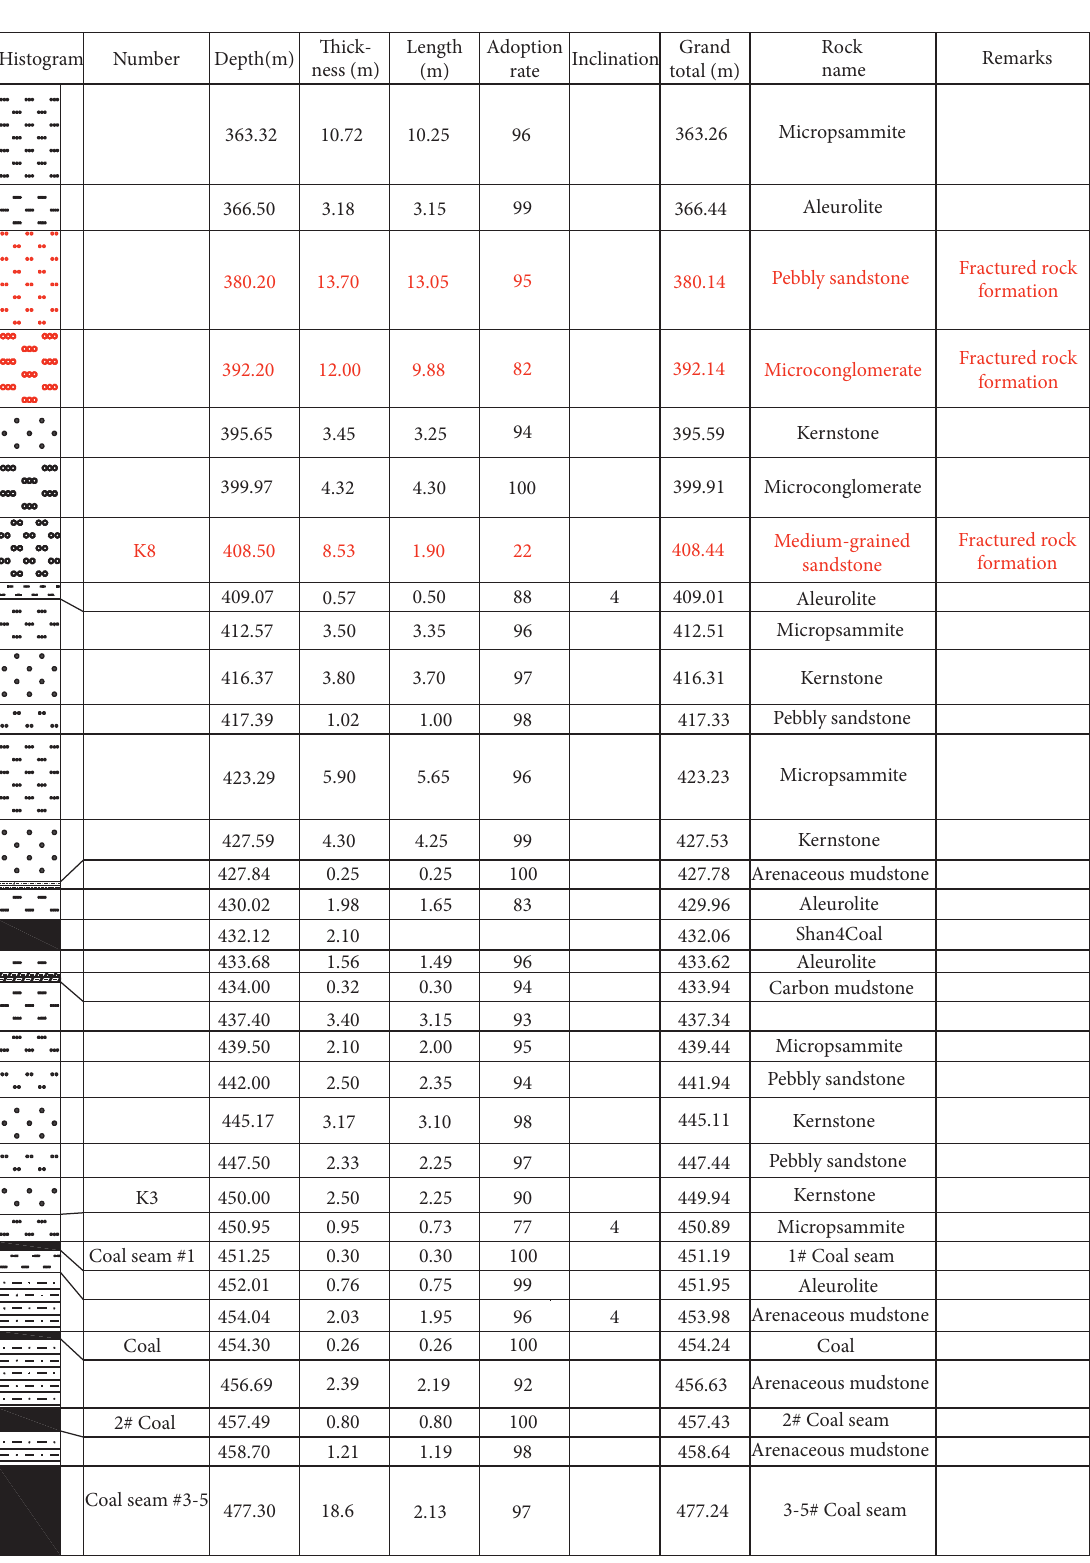
Figure 8: Location map of the cracking target